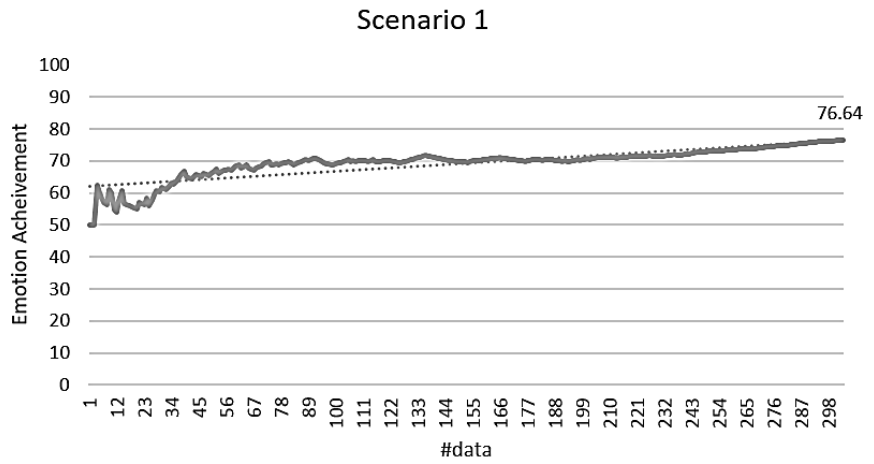
Figure 15. Emotion achievement for scenario 1. The thick line shows the increase of the achievement according to the number of sensory changes, and the dotted line shows the trend of this increase.